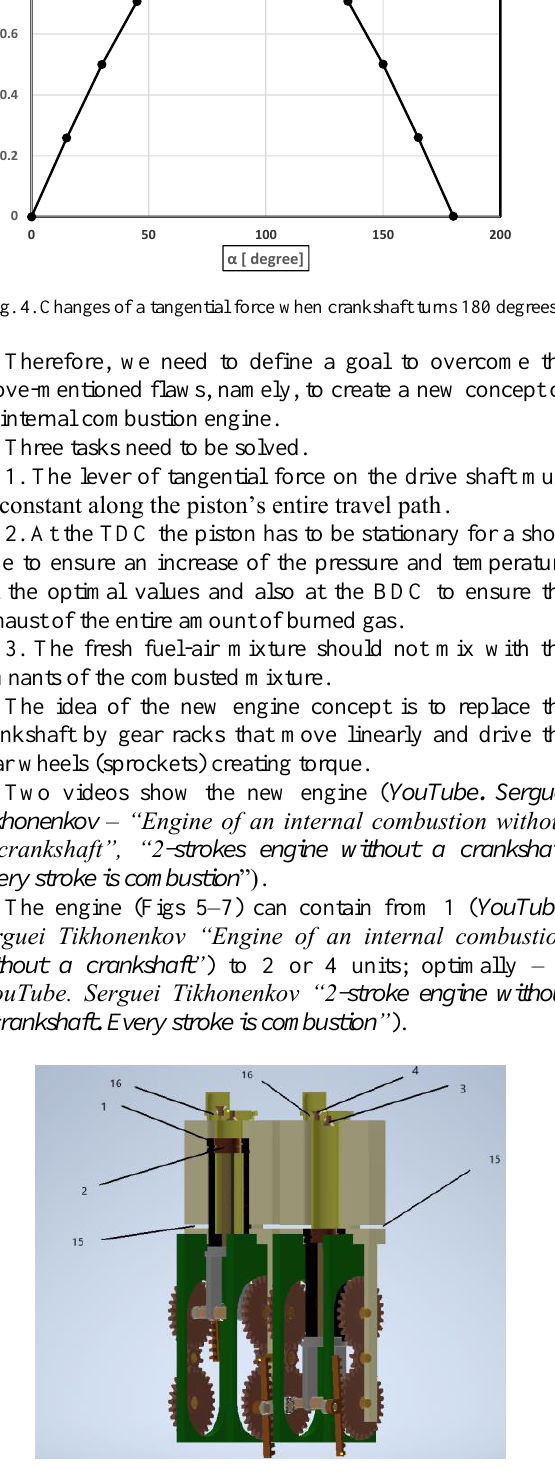
Fig. 5. 2-stroke engines without